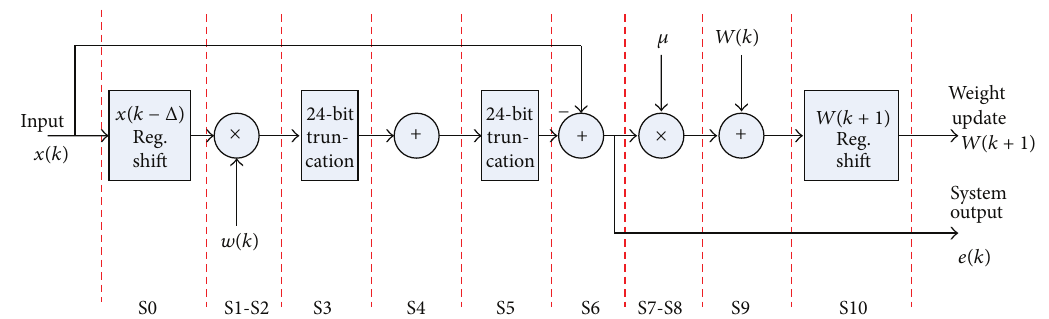
Figure 4: ALE computation